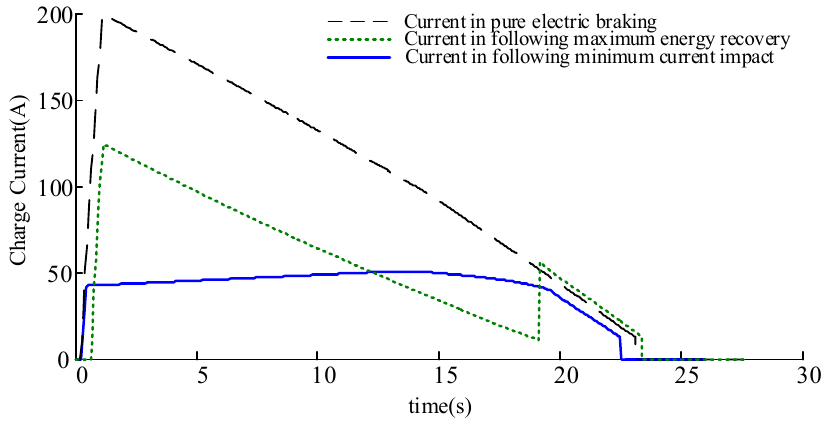
Figure 14. Vehicle braking deceleration curve.